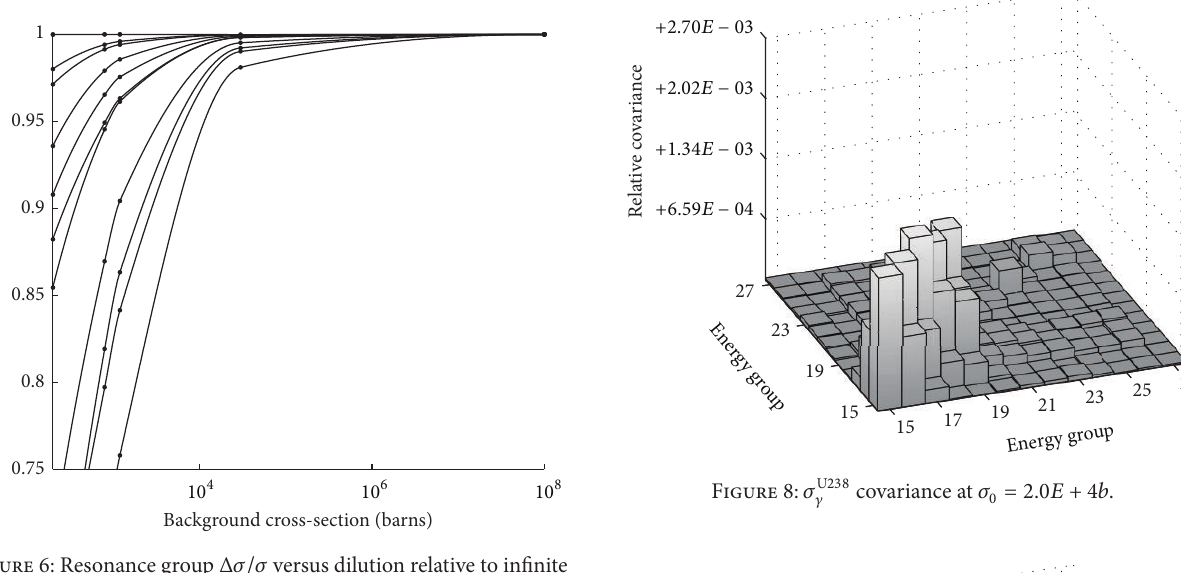
Figure 6: Resonance group Δ𝜎/𝜎 versus dilution relative to infinite dilution of 𝜎 U 235 𝛾 using TMC.